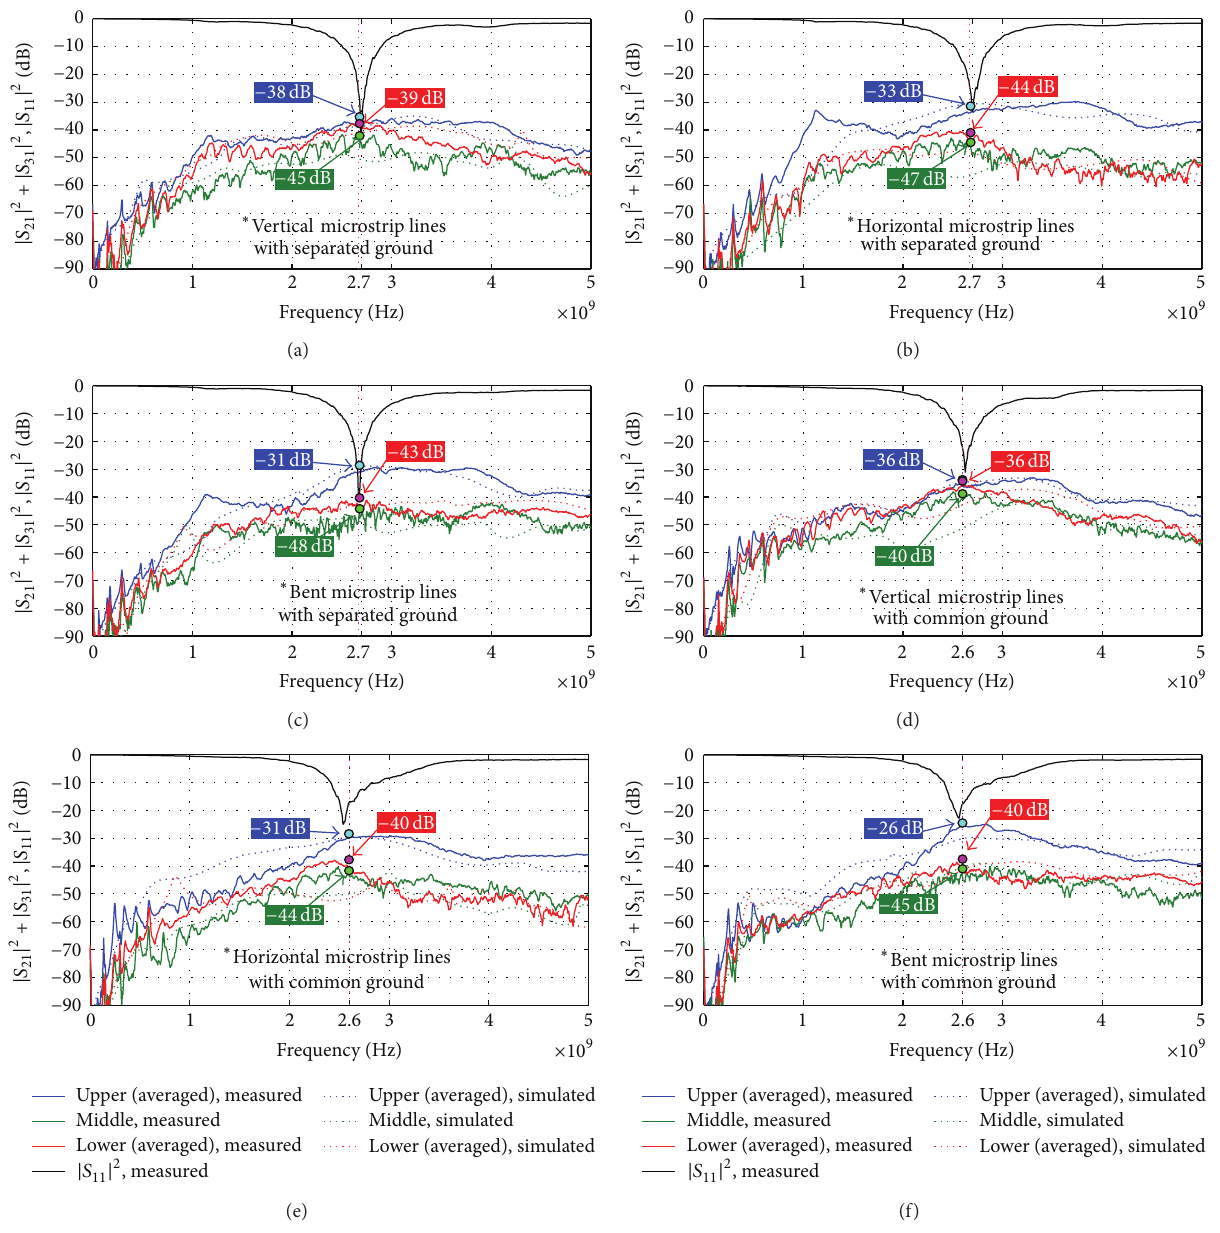
Figure 12: Measured and simulated power transfer from antenna to the multiple (five) microstrip transmission lines with/without ground connection: (a) vertical microstrip lines with separate ground, (b) horizontal microstrip lines with separate ground, (c) bent microstrip lines with separate ground, (d) vertical microstrip lines with common ground, (e) horizontal microstrip lines with common ground, and (f) bent microstrip lines with common